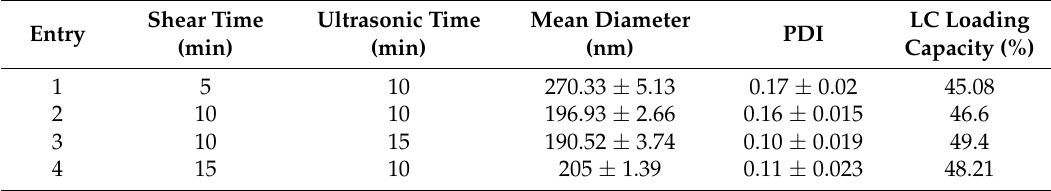
Table 1. Effects of shear and ultrasonic times on the size, size distribution, and LC loading capacity of LC/PLA nanoparticles a .